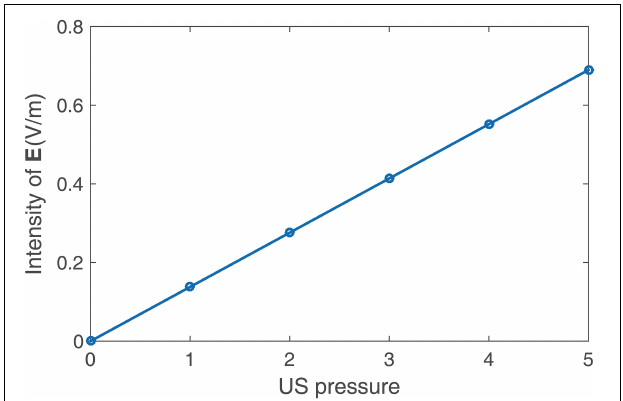
FIGURE 6 | Intensity of the E-field at different US pressures in the